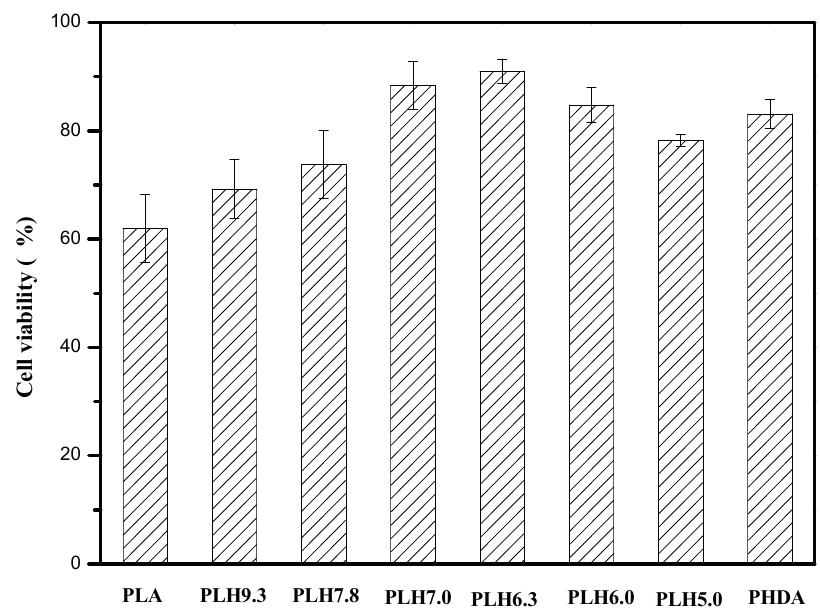
Figure 8. Cell viability of the PLH copolymers after incubation with NIH/3T3 cells for 24 h.